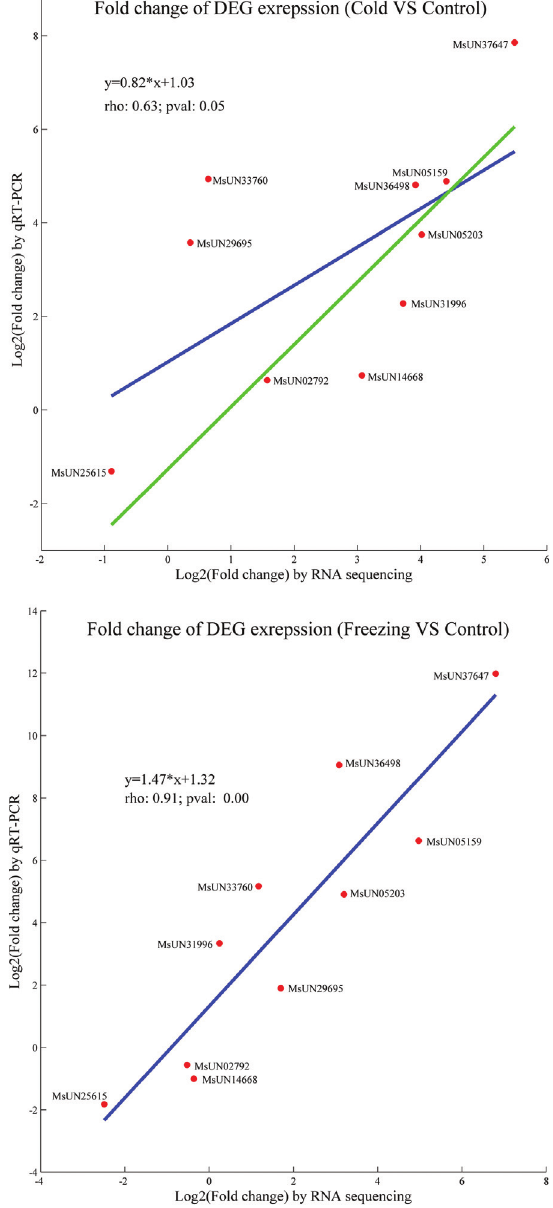
Figure 8 - Comparison of the expression of ten MsERF genes between RNA-seq and qRT-PCR platforms in response to cold and freezing stress. Red dots are plot-based fold changes of each MsERF gene between the abundance from transcriptome sequencing and qRT-PCR detection. The line correction relationship was computed based on the expression of ten MsERF genes (blue line), while the green line was computed based on eight MsERF genes, eliminating MsUN29695 and